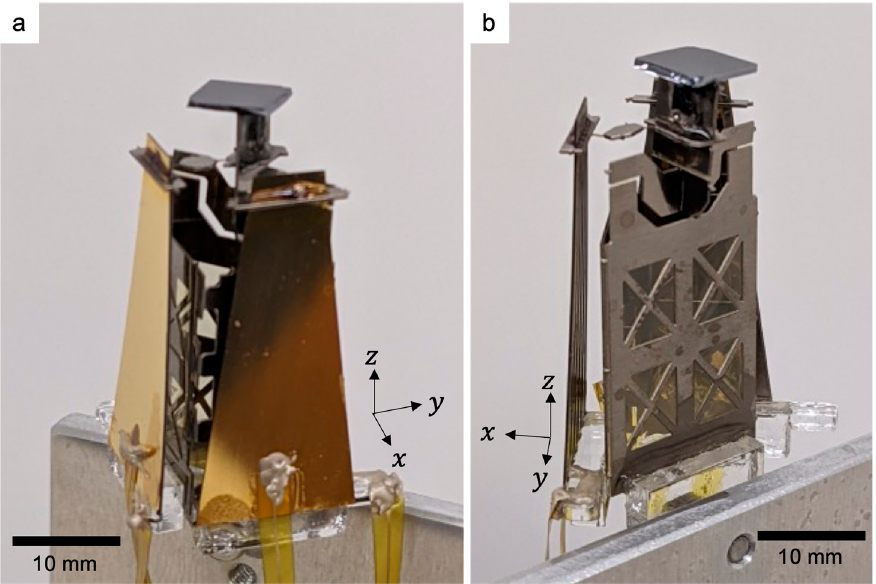
Figure 10. Photograph of fabricated scanner: ( a ) and ( b ) show the identical device viewed from different angles.